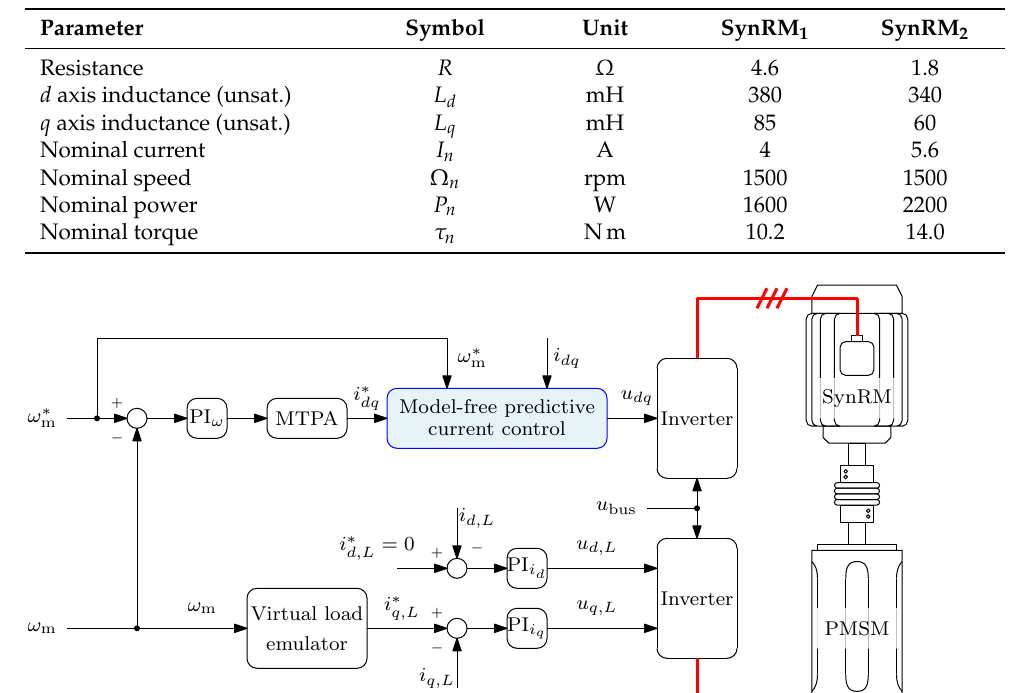
Figure 3. Experimental setup for the proposed paper. Table 1. Motors under test nameplate parameters.